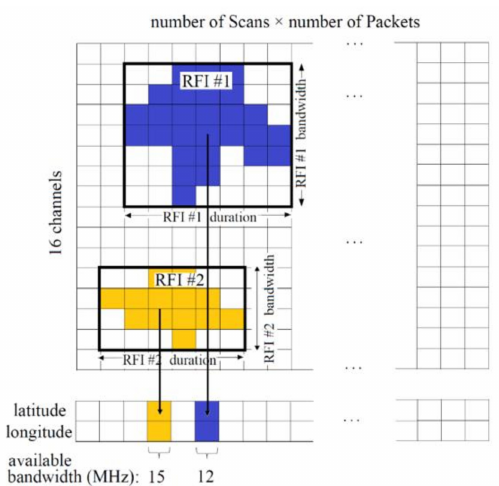
Figure 3. Extracting RFI properties using MATLAB’s “bwconncomp” and “regionprops” functions on maximum probability of detection (MPD) RFI flags. In this example, two separate RFI sources ( RFI #1 in blue and RFI #2 in yellow) were identified by the “bwconncomp” function, and the “regionprops” function provides their bandwidth ( RFI #1 bandwidth = 7 × 1.5 MHz and RFI #2 bandwidth = 4 × 1.5 MHz) and duration ( RFI #1 duration = 7 × 1.2 ms and RFI #2 duration = 6 × 1.2 ms). SMAP Level 1A data also include geolocation information, thus these RFI sources can be assigned to particular locations based on their mid-point in